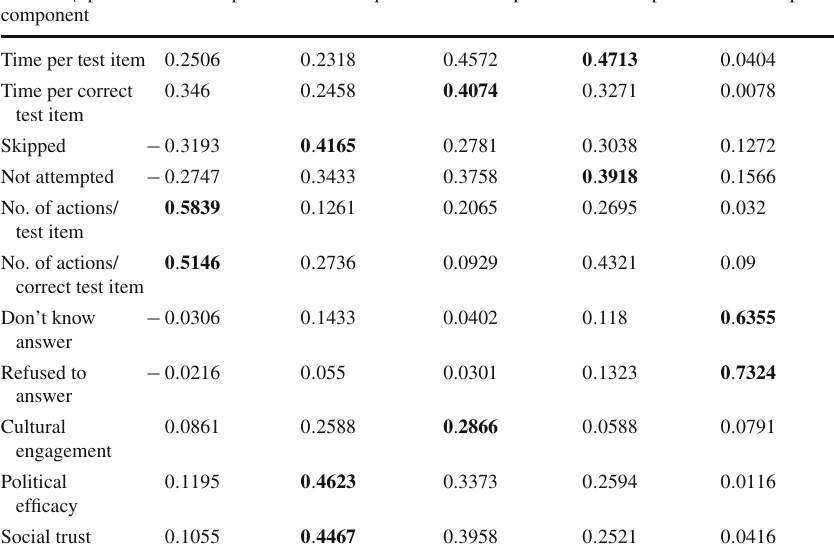
Table 11 Correlation between principal components and variables for non-cognitive skills Variable \ Ppal